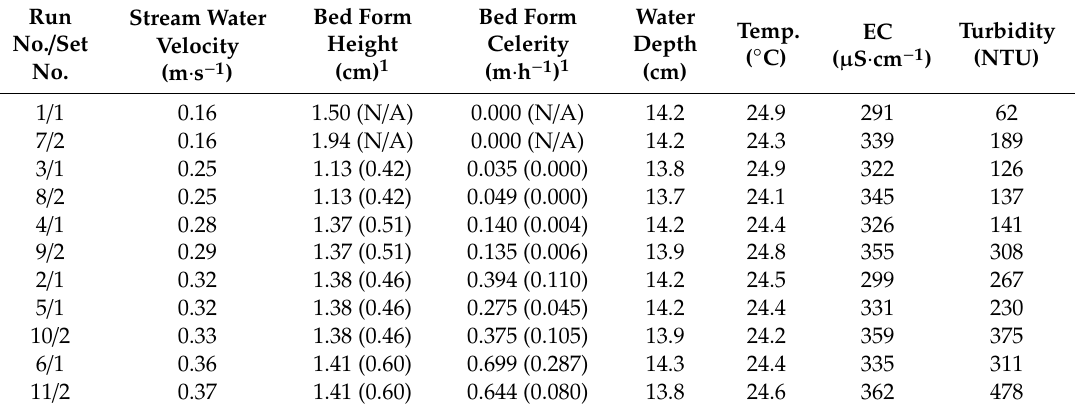
Table 1. Physical and chemical properties of the water and sediment during the